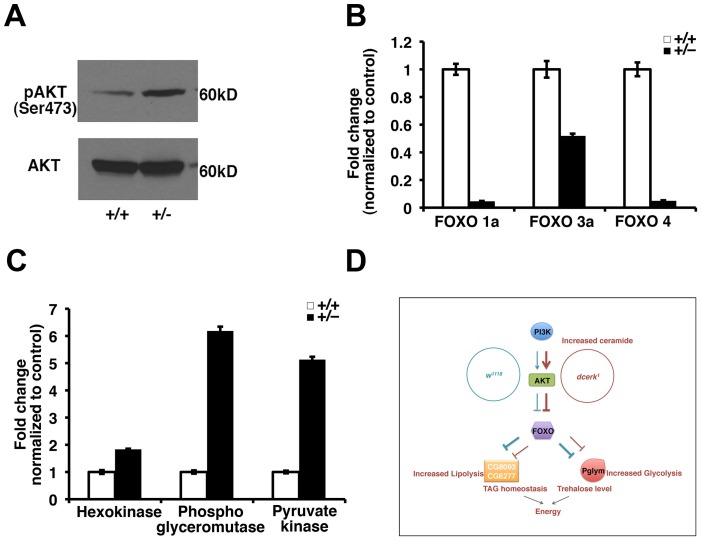
Activation of AKT, decrease in FOXO and activation of glycolytic genes in CERT heterozygous mice.(A). Total AKT and phosphoAKT levels are monitored in liver extracts from wild type (+/+) and CERT heterozygous (+/−) mice. PhosphoAKT level is increased in CERT heterozygotes while total AKT is not significantly changed. (B). Comparison of different FOXO in liver tissue of wild type (+/+) and CERT heterozygous (+/−) mice shows significant decrease in their transcript levels. (C). Comparison of glycolytic genes in skeletal muscle from wild type (+/+) and CERT heterozygous (+/−) mice shows greater than 5 fold increase in transcript levels of phosphoglycerate mutase and pyruvate kinase and 1.8 fold increase in hexokinase. (D). A simple graphical model depicting metabolic reprogramming in dcerk1 due to increased AKT activation and decreased FOXO to maintain energy balance. dcerk1 mutants show glucose utilization through increased glycolytic flux mediated by Pglym and downstream enzymes. They also show increased utilization of triglycerides mediated by CG8093 and CG6277.